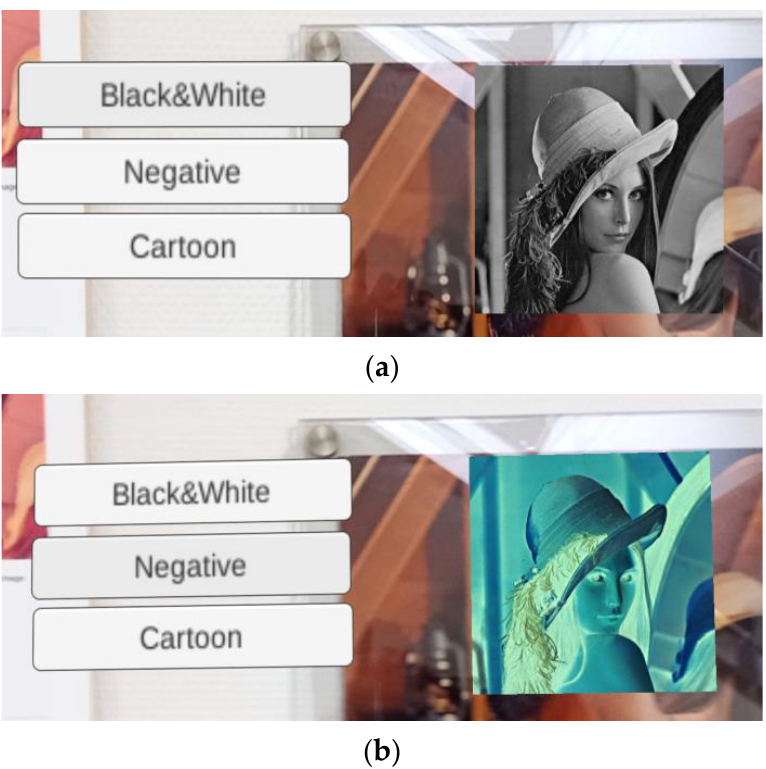
Figure 2. Lenna interactive AR object: ( a ) applying black and white image processing; ( b ) applying negative image processing.